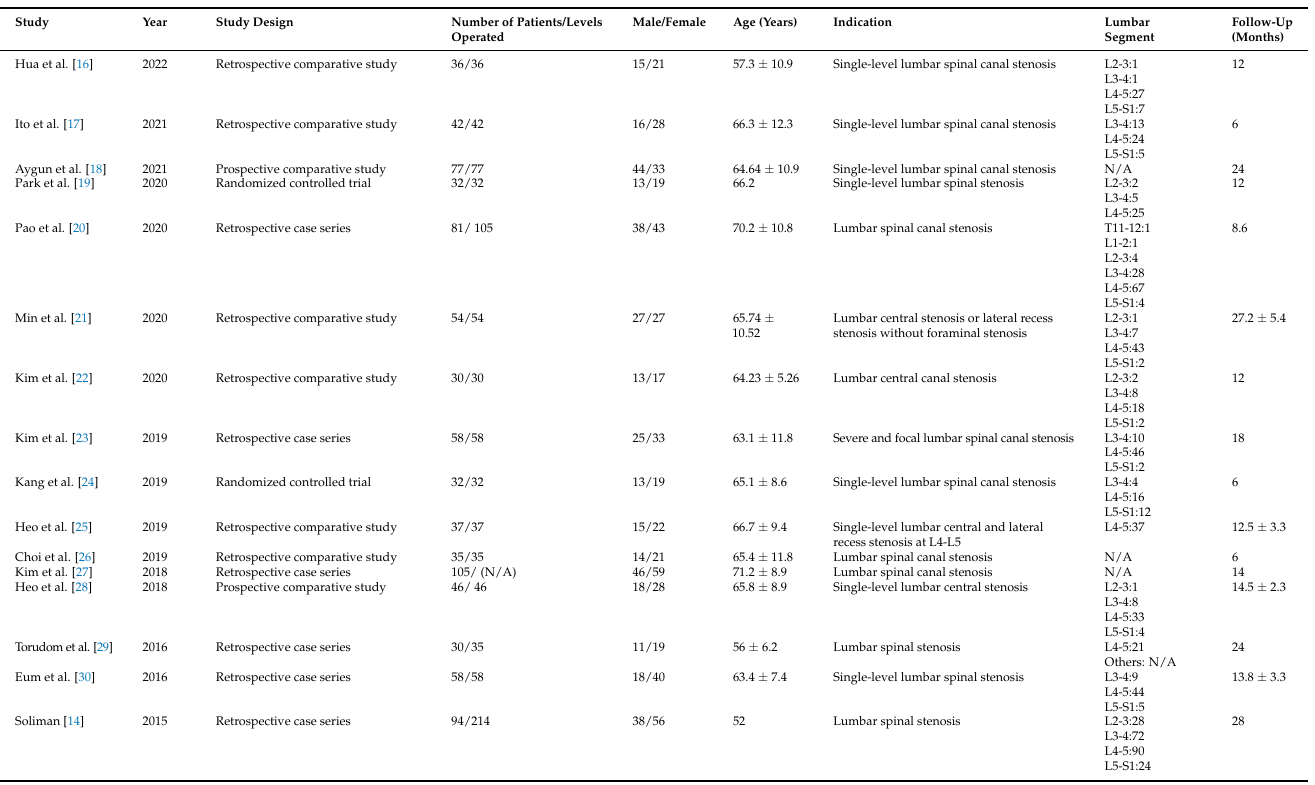
Table 1. Characteristics of articles describing the interlaminar approach.